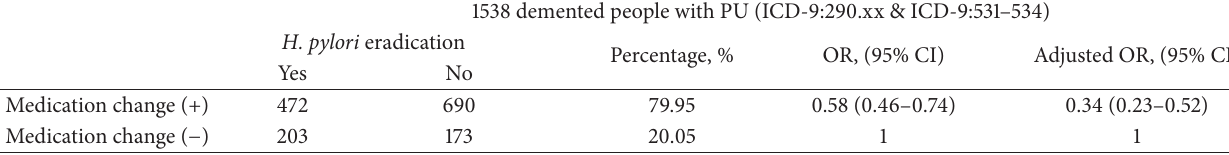
Table 2: The effect of H. pylori eradication on the progression of